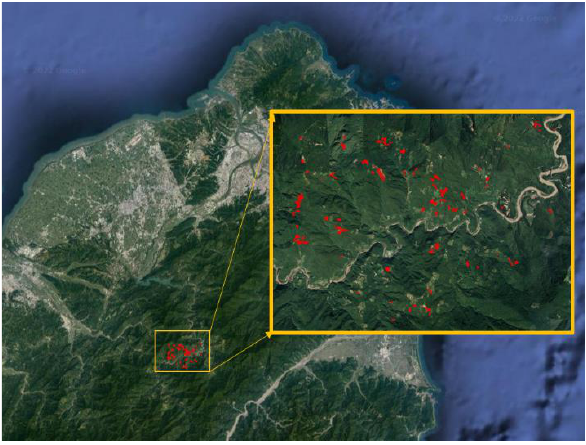
Figure 9. Landslide area location